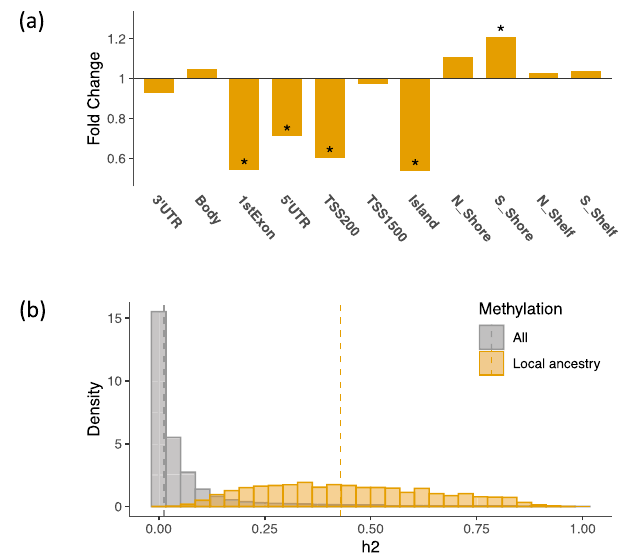
Fig. 4 Downstream characterization of the local ancestry-associated DNA methylation. a The enrichment or depletion of genomic annotations for the DNA methylation identi fi ed in the epigenome-wide association studies (EWAS) of local ancestry. Asterisks (*) indicate signi fi cant enrichments or depletions with FDR adjusted p -values less than 0.05. b The SNP-based heritability estimates of local ancestry associated DNA methylation (mean h 2 = 0.45, median h 2 = 0.43) are considerably higher than the overall heritability (mean h 2 = 0.06, median h 2 = 0.01) estimated from all methylation sites. The SNP-based heritability for each methylation site is estimated using all SNPs in a fl anking region of 1 mega basepairs. The source data are provided in Table 2 and Supplementary Data 4.